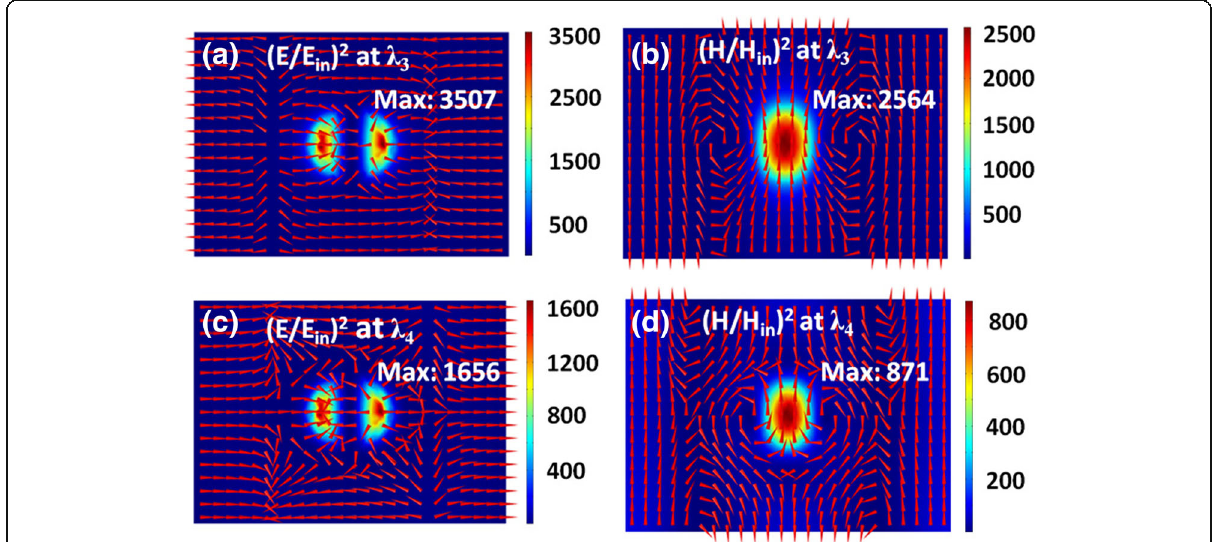
Fig. 5 a – d The same as in Fig. 4 but at the resonance wavelengths of λ 3 and λ 4 labeled in Fig.